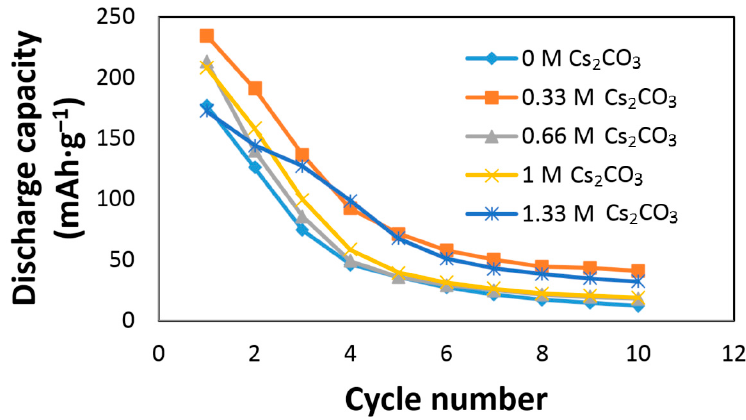
Figure 2. Discharge capacities of AR3 in 6.77 M KOH, 6.44 M KOH + 0.33 M Cs 2 CO 3 , 6.11 M KOH + 0.66 M Cs 2 CO 3 , 5.77 M KOH + 1.00 M Cs 2 CO 3 , and 5.44 M KOH + 1.33 M Cs 2 CO 3 electrolytes.